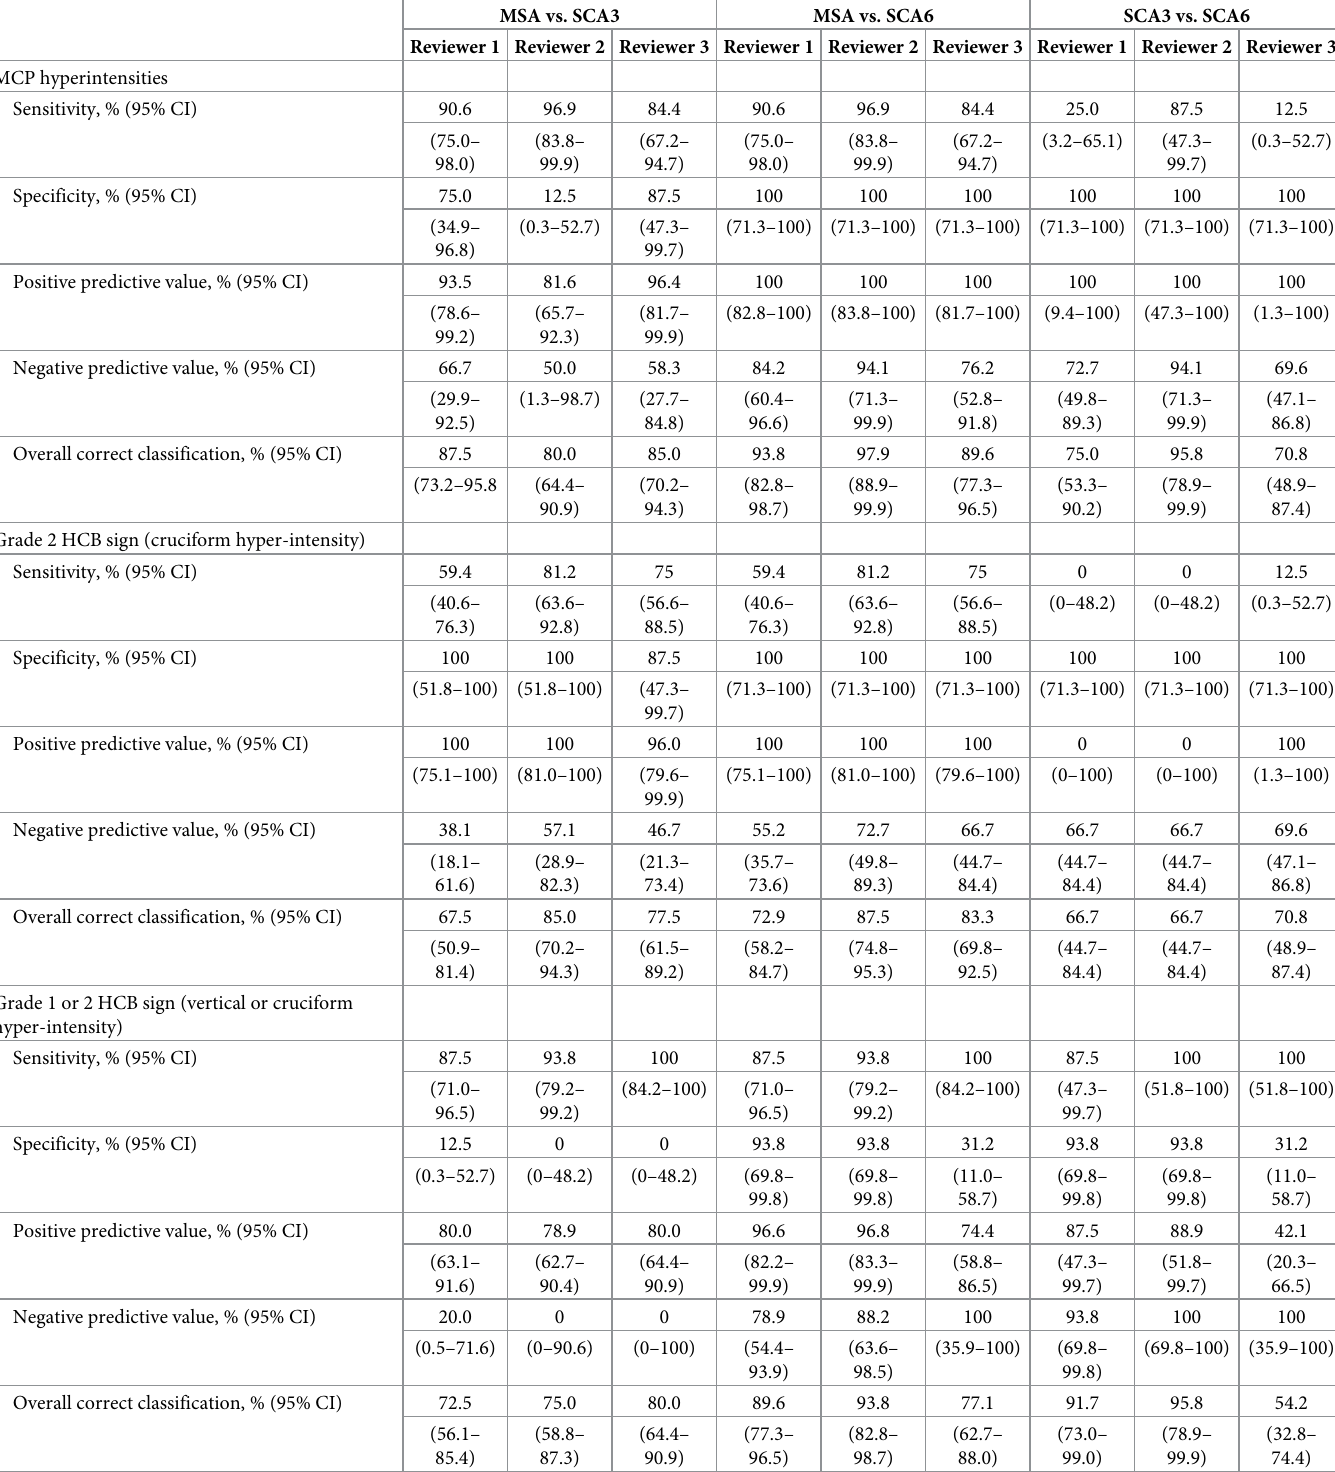
Table 2. Visual evaluation of the Middle Cerebellar Peduncle (MCP) hyperintensities and hot cross bun sign for cerebellar subtype multiple system atrophy (MSA-C) and spinocerebellar ataxia type 3 (SCA3) and 6 (SCA6). MSA vs. SCA3 MSA vs. SCA6 SCA3 vs.